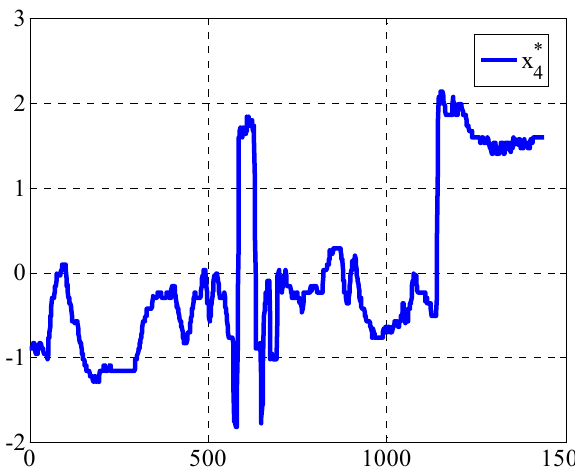
of carbon content of fly ash (1# boiler). 4